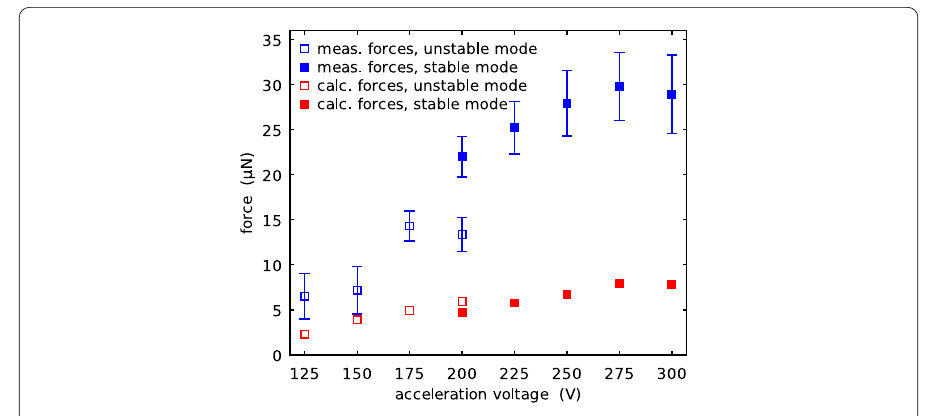
Figure 8 Energy-dependent measurement of forces at a gas flow of 10 sccm through the Hall thruster. Note the two operating modes depending on the acceleration voltage. The calculated forces are based on the measured current onto the probe